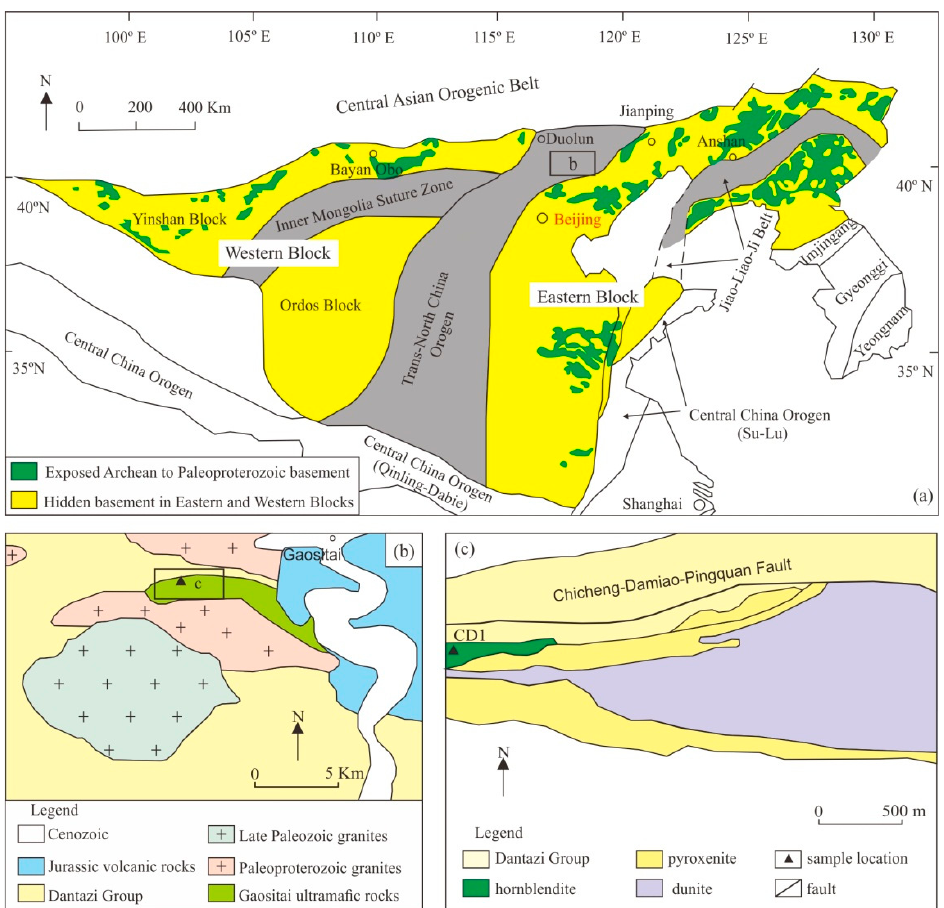
Figure 1. Tectonic subdivision of the North China Craton, modified from Zhao et al. and Santosh [21,23] ( a ); simplified geological map of the Gaositai area in Northern Hebei ( b ); and a detailed geological map of Gaositai mafic-ultramafic rocks, modified from Chen et al. [33] ( c ).